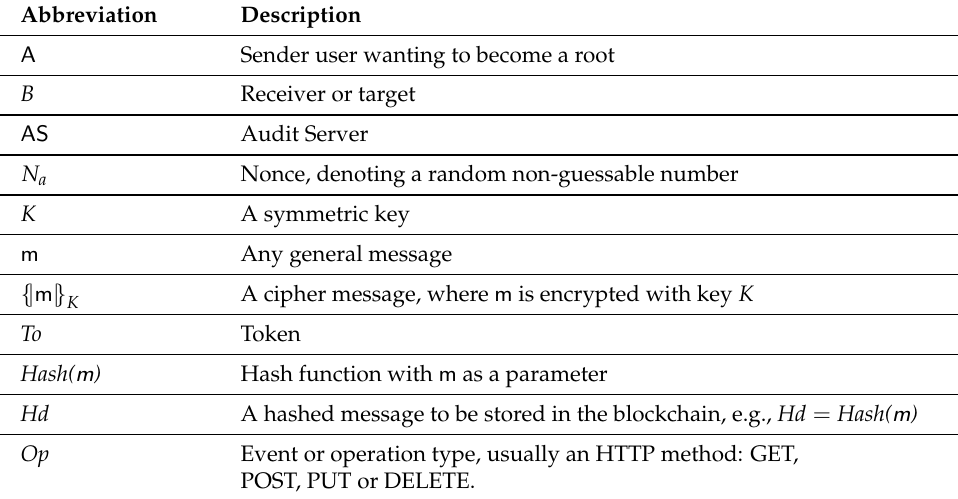
Table 2. Notation: short